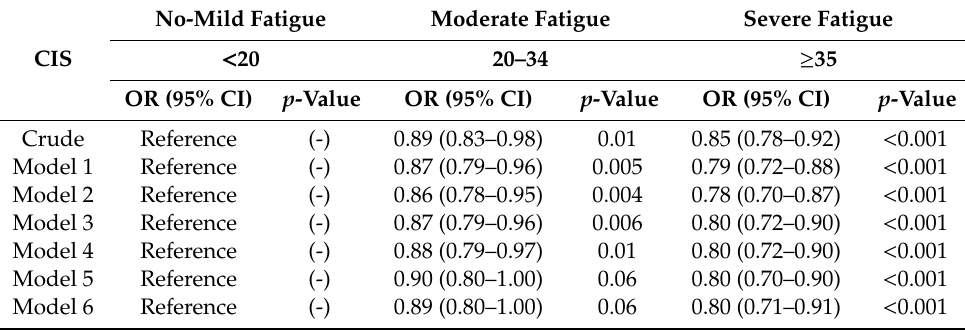
Table 2. Association of protein intake (per 10 g / d increment) with fatigue in KTR.